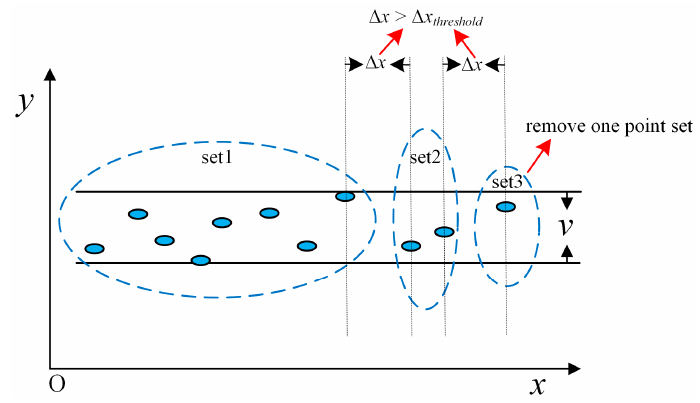
Figure 2. An illustration of OBS extraction for the y -coordinate.